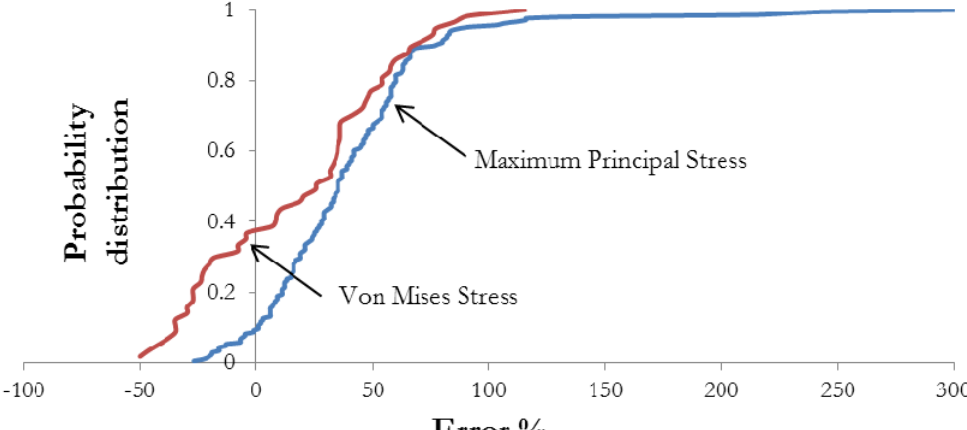
Figure 6: Probability distribution of the error predictions using the maximum principal stress for all data and Von Mises stress for semi-ductile and ductile